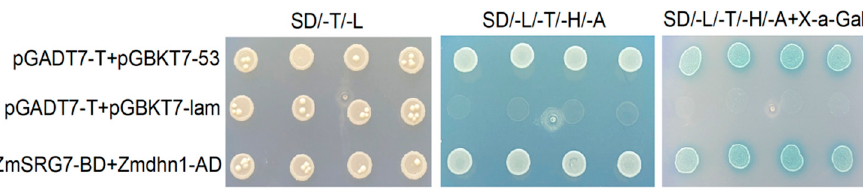
Figure 8. Validation of interaction between ZmSRG7 and Zmdhn1 in yeast. pGBKT7-53 + pGADT7-T: positive control; pGBKT7-Lam + pGADT7-T: negative control; pGBKT7-ZmSRG7 + pGADT7-dhn1: experimental group.